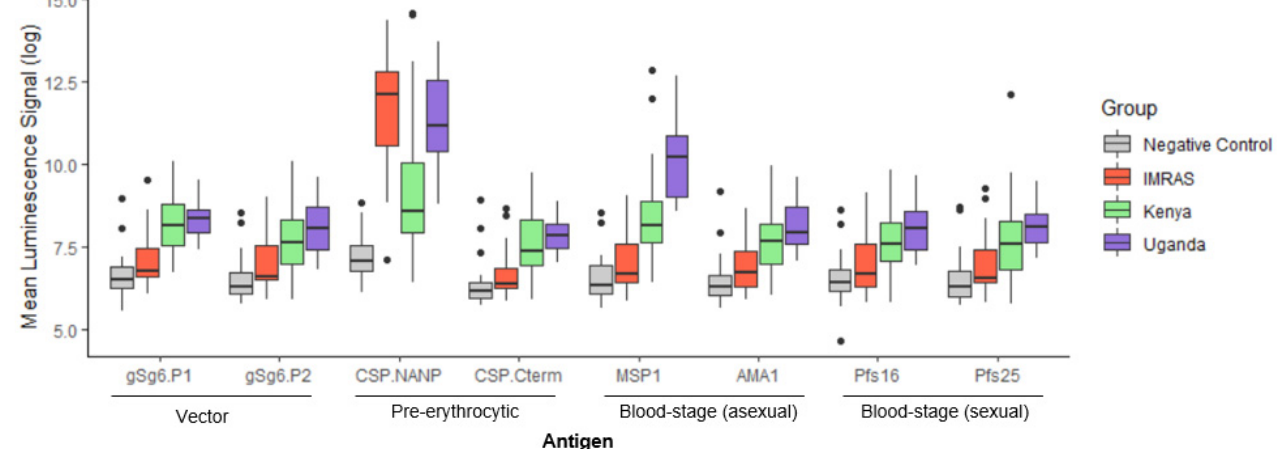
Figure 3. Specific antibody profiles from samples collected in endemic regions. The multiplex assay was tested against samples collected from Kericho, Kenya, from 2011–2014, which historically has low to moderate malaria-transmission intensity, and from Kampala, Uganda, from 2011–2018, which historically has high malaria-transmission intensity. Data from negative controls and the IMRAS samples are shown for comparison. Black dots represent outliers.